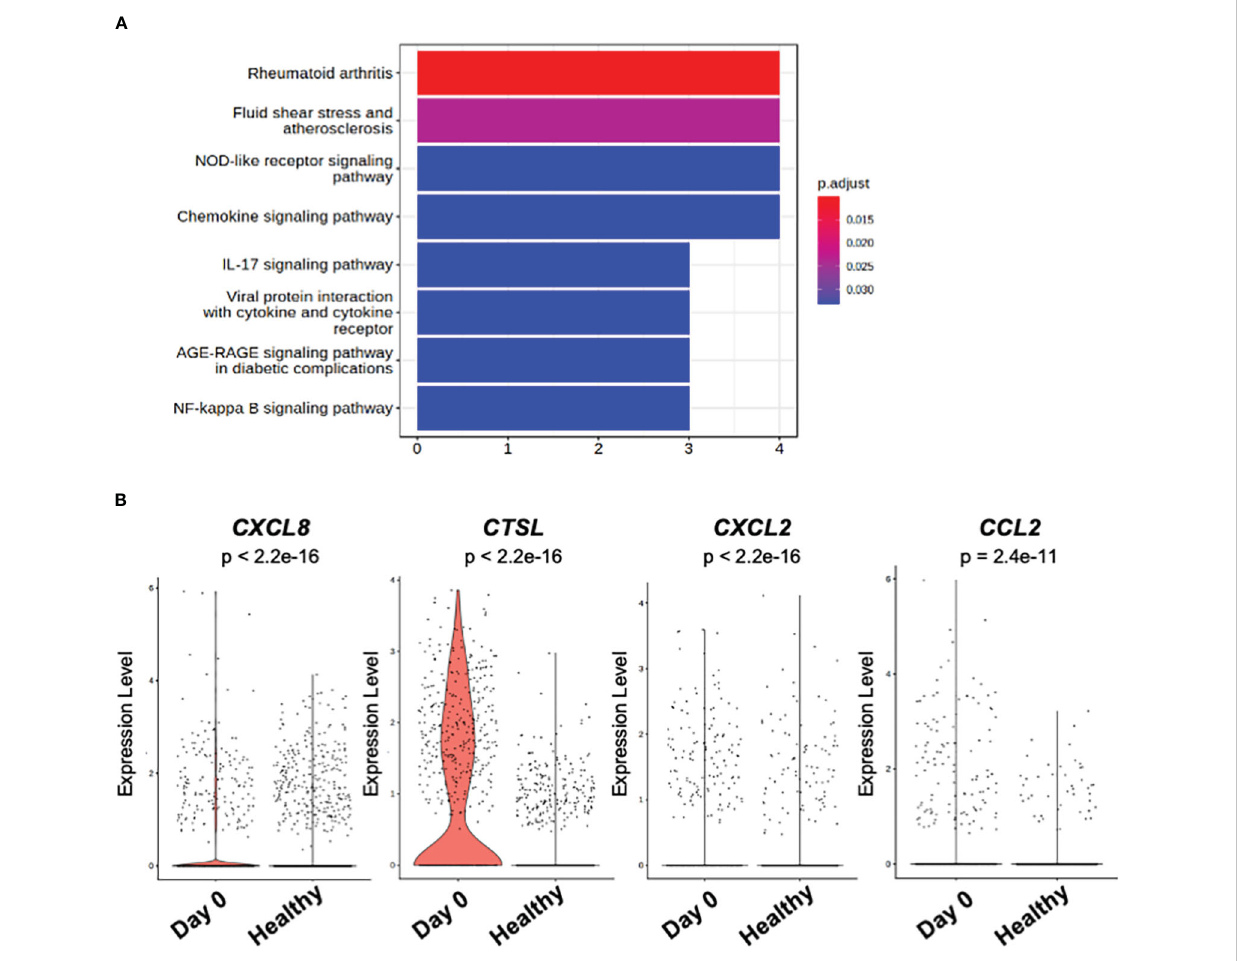
FIGURE 4 KEGG pathway and DEG analysis of classical monocytes. (A) Bar plot of KEGG pathway enriched in signi fi cantly (p_val_adj < 0.1 and |avg_log2FC| > 1) up-regulated genes among classical monocytes at day 0 and day 3 of the patient. (B) Violin plot of the genes related to KEGG pathway term “ Rheumatoid arthritis ” in (A) . “ Day 0 ” depicts the samples obtained from the patient on day 0. “ Healthy ” depicts the samples obtained from the public healthy control data